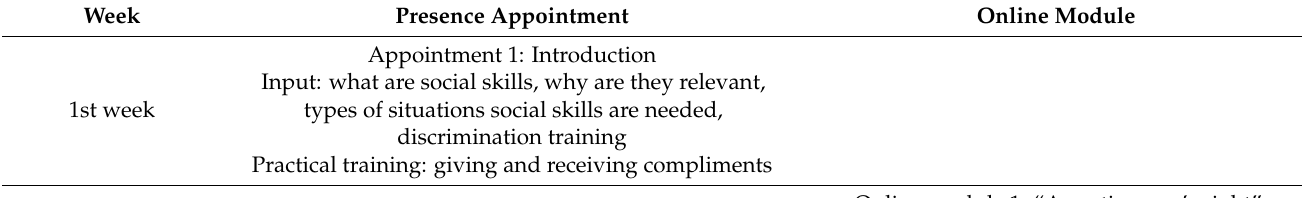
Table 1. Content of Blended Group